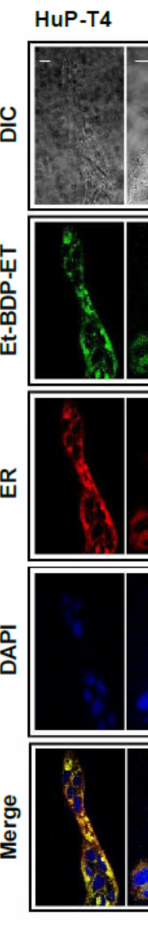
Figure 7. Edelfosine colocalizes with the ER in human pancreatic cancer cells. HuP-T4 and Capan-2 pancreatic cancer cells, transfected with an ER-targeted red fluorescence calreticulin plasmid to visual- ize the ER (red fluorescence), were incubated with the fluorescent edelfosine analog Et-BDP-ET (green fluorescence). Cell nuclei were also stained with the fluorophore 4 (cid:48) ,6-diamidino-2-phenylindole (DAPI) (blue fluorescence). Areas of colocalization between the ER and Et-BDP-ET in the merge panels are yellow. Bar, 10 µ m. DIC: differential interference contrast microscopy. See text for details. Image taken from